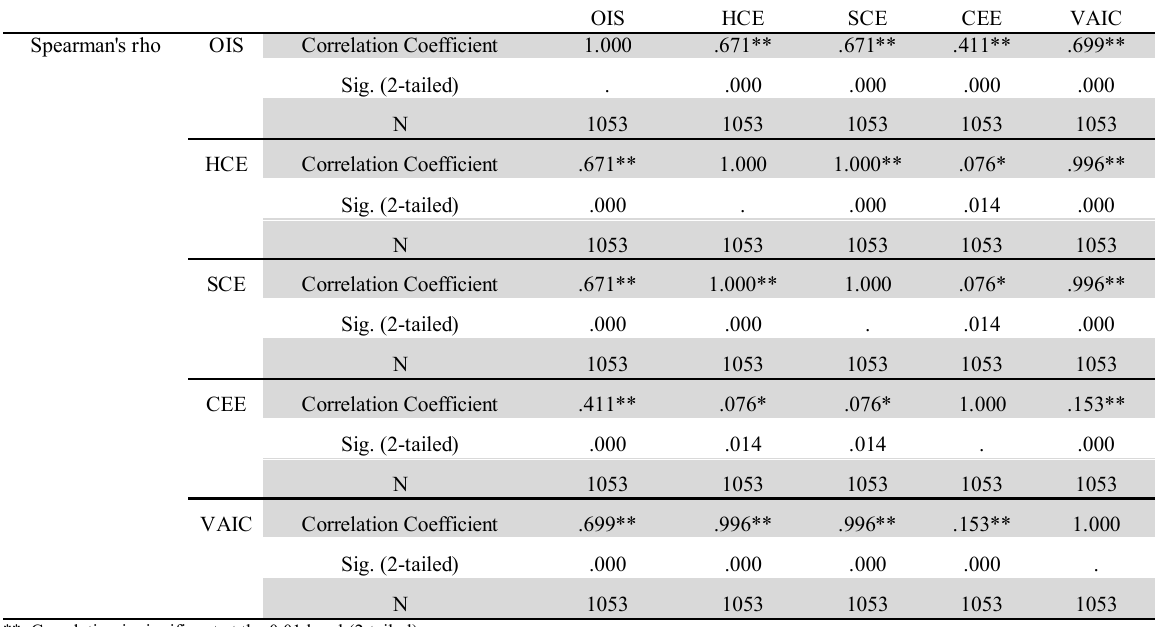
The summary Spearman’s corrlations